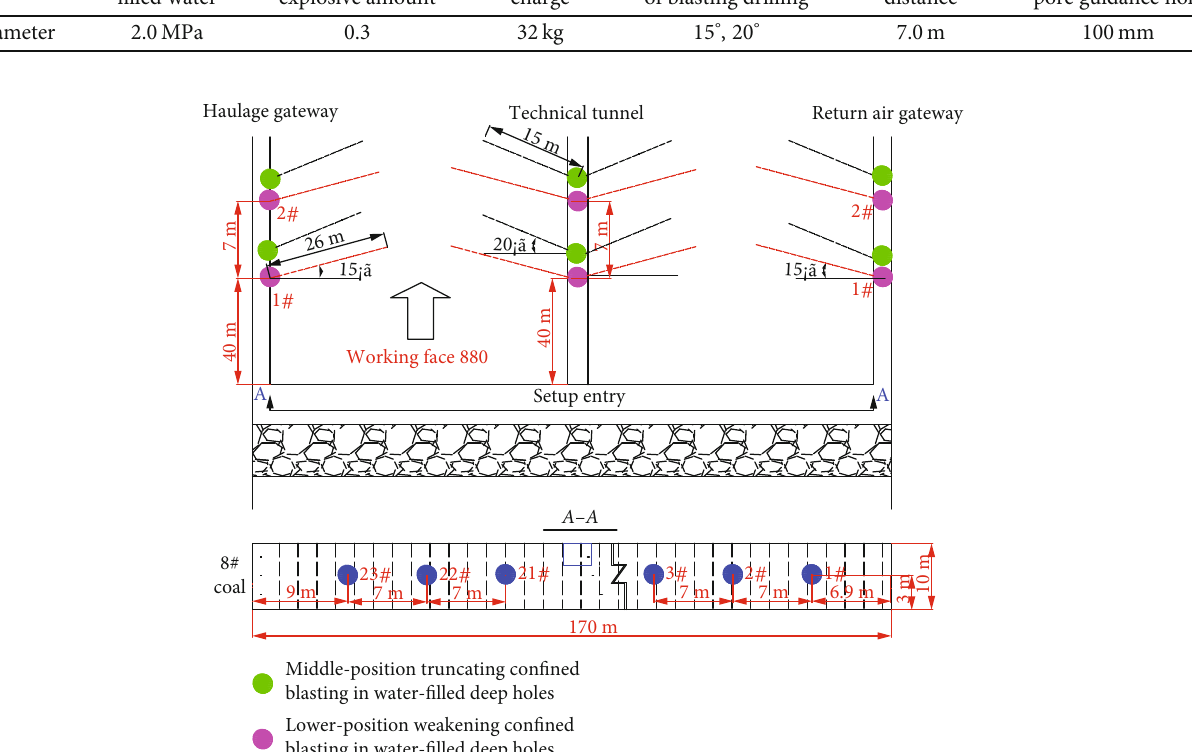
Figure 9: Deep hole con fi ned blasting drilling arrangement of THR in working face 880 of the Zhuxianzhuang Coal